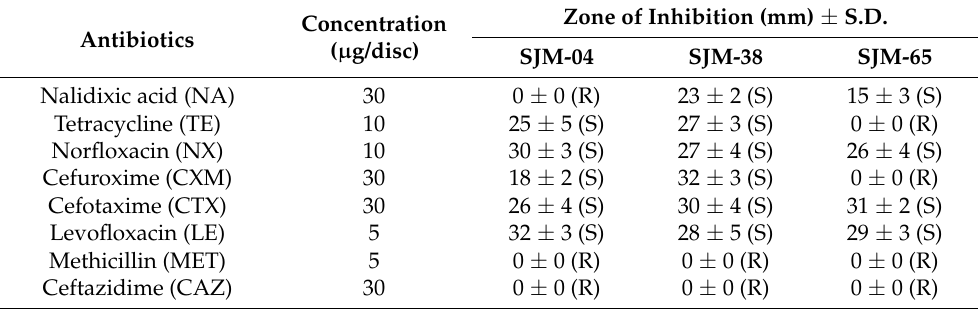
Table 1. Antibiotic sensitivity profiling of Gram positive coccoid oral bacterial isolates. Antibiotics